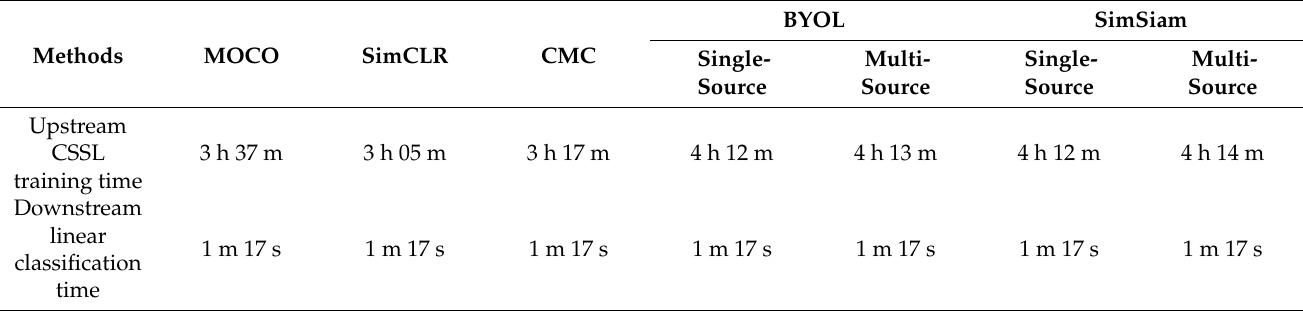
Table 2. Training time of CSSL methods (h: hours, m: minutes, s: seconds).